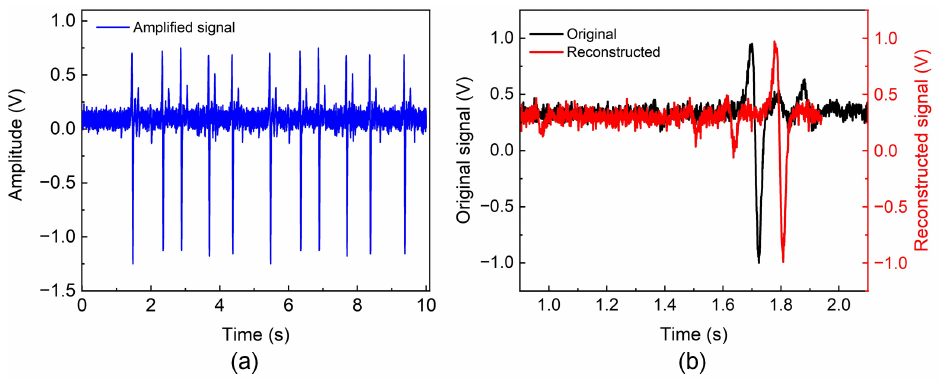
Figure 7. ( a ) Amplified synthetic neural signal, ( b ) reconstructed signal after the digital to analog